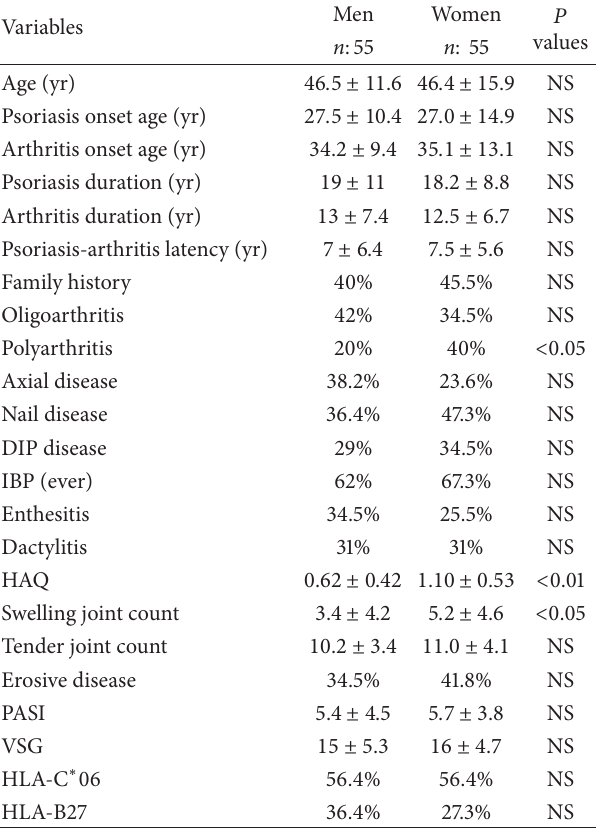
Table 1: Clinical characteristics of the study